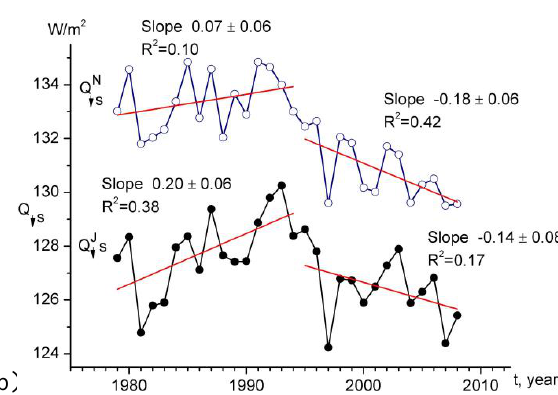
(b) over ATR using JRA-25 reanalysis for the period 1979-2008. 2  S